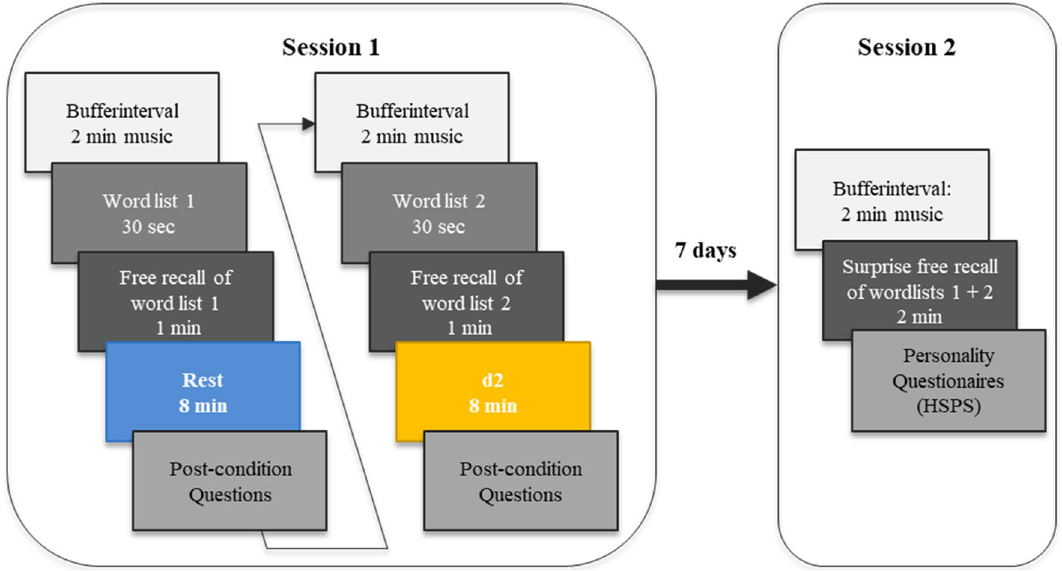
Figure 1. Experimental procedure. The experiment consisted of two experimental sessions (Session 1 and 2) separated by 7 days. In Session 1, participants completed two word-learning phases, in which they encoded and immediately recalled two word lists. In each phase, the critical manipulation occurred during an 8-min delay, where participants either wakefully rested or performed the d2 test of attention. Following the post-encoding activity participants rated how they felt and whether they rehearsed the words. The order of post-encoding activities and the order of presented word lists were counterbalanced across participants. Seven days later, participants performed a surprise free-recall test for both word lists in Session